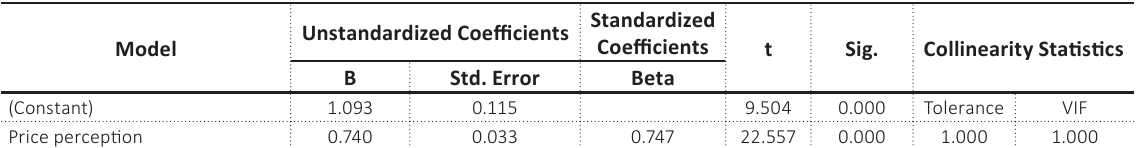
Table 7. Regression results (price perception and customers’ repurchase intention) Model